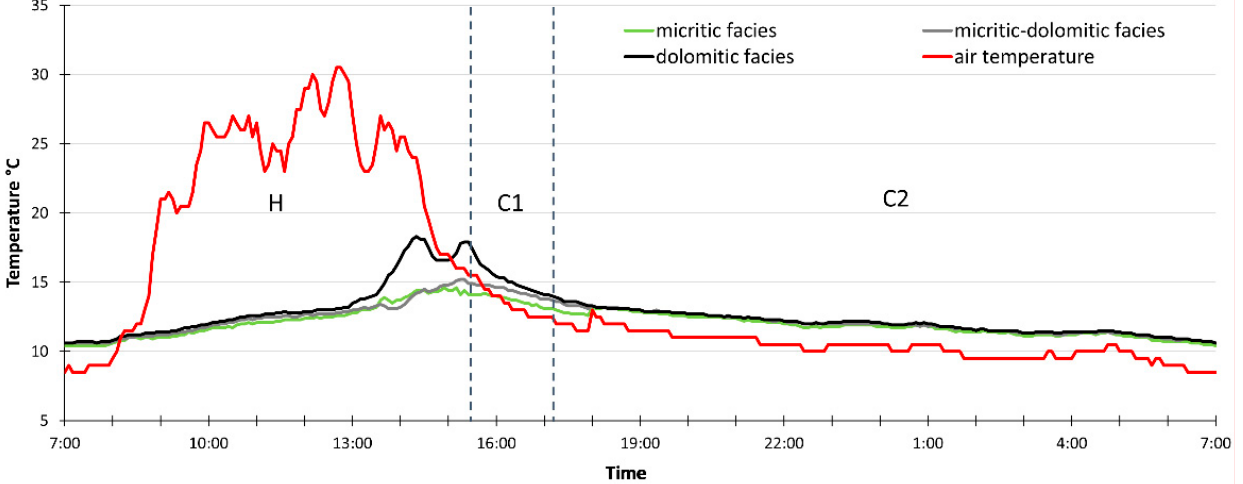
Figure 6. Air temperature and rock temperature directly measured on the outcropping lithofacies